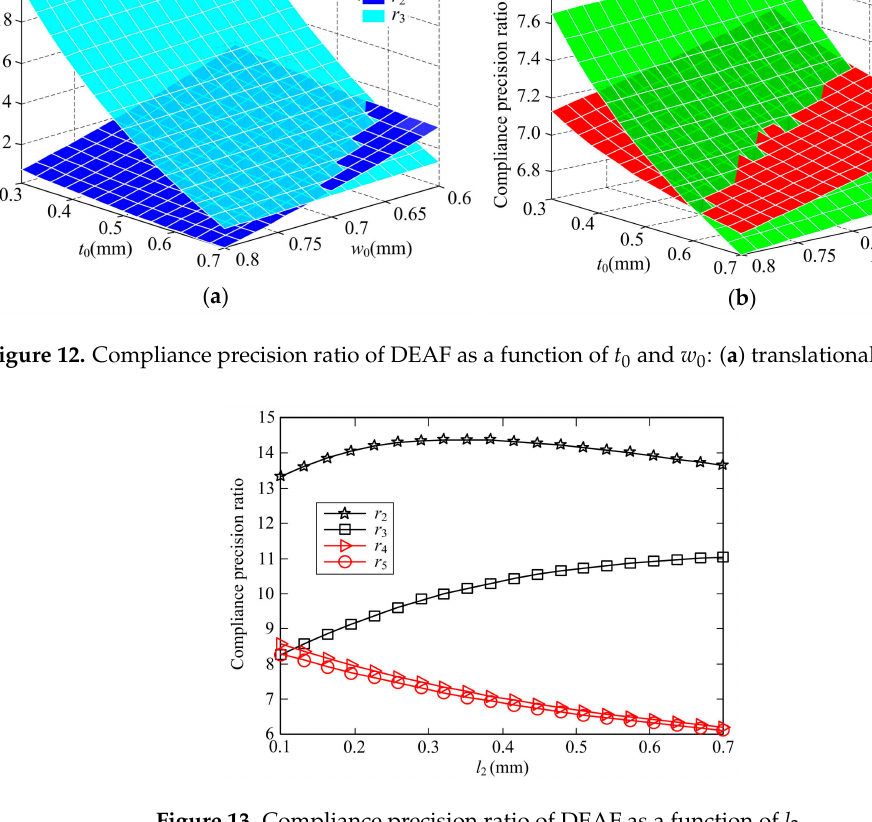
Figure 13. Compliance precision ratio of DEAF as a function of l 2